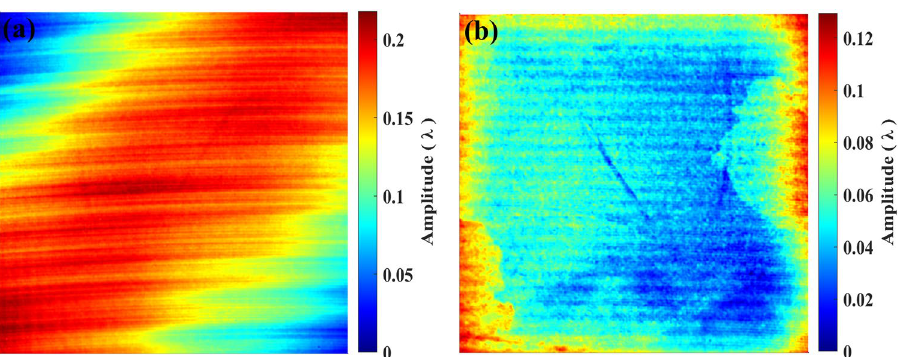
Figure 14. The (010) SPDT surface of the bulk single-crystal KDP with a dimension of 40 mm × 40 mm × 10 mm: ( a ) before AFJP and ( b ) after AFJP using the BT.